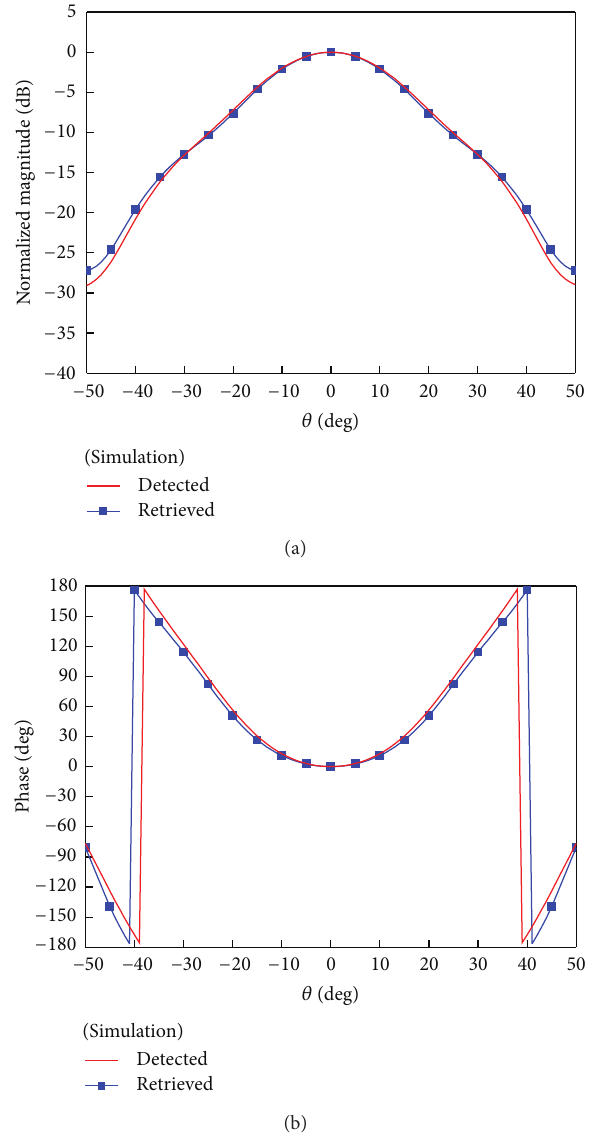
Figure 3: Fresnel field pattern from the simulation: (a) detected and retrieved magnitudes and the (b) exact and retrieved phases.